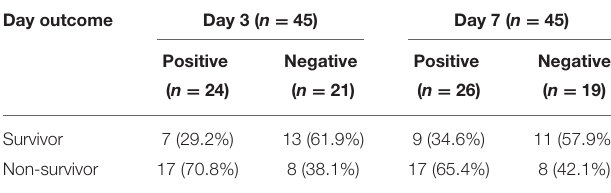
TABLE 1 | Fluid balance status in the first 3 and 7